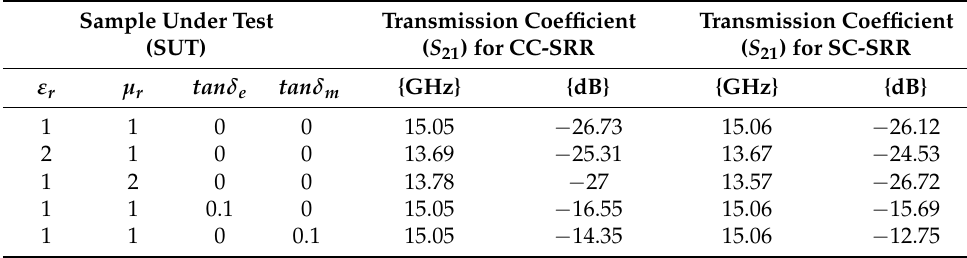
Table 2. The influence of the electromagnetic properties of the SUT on the resonance frequency and notch depth of the CC-SRR and SC-SRR